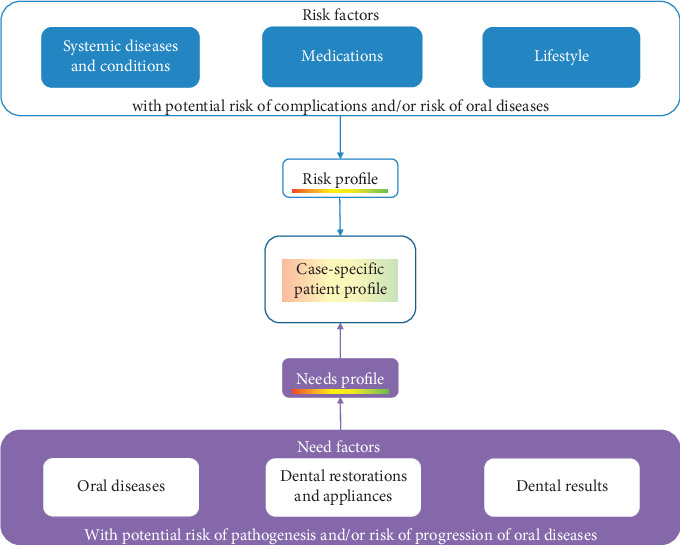
The synthesis of a risk and needs profile leads to the case-oriented patient profile, which determines the general framework, content, and frequency of the prevention cycle for the individual patient.